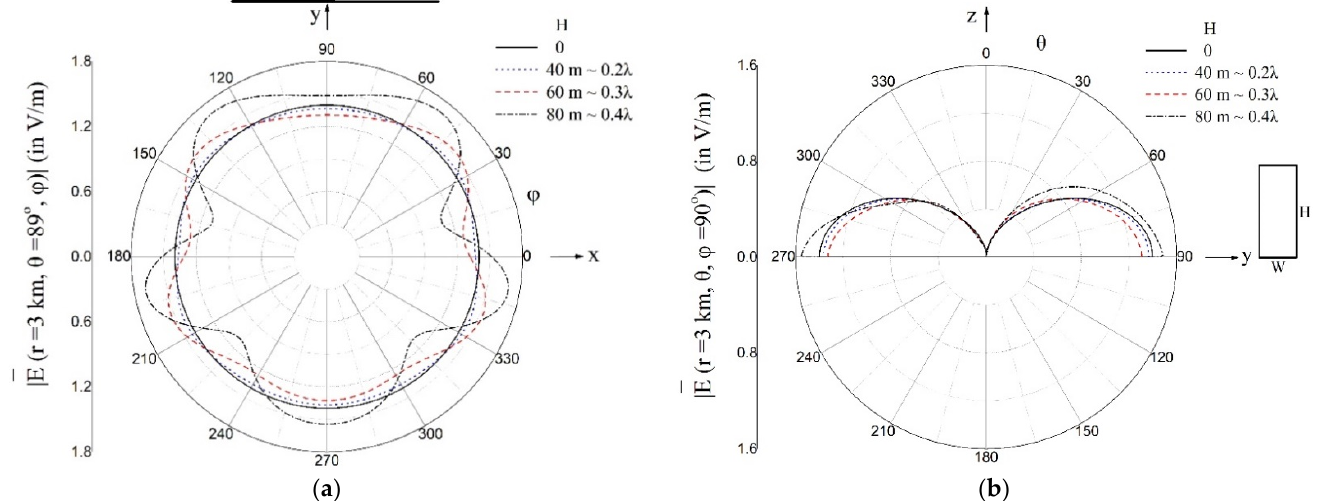
Figure 5. The same as Figure 4, except for the distance between the antenna and the building ( 𝑅 = 200 m ≈ 𝜆 ). ( a ) φ -plane and ( b ) θ -plane.